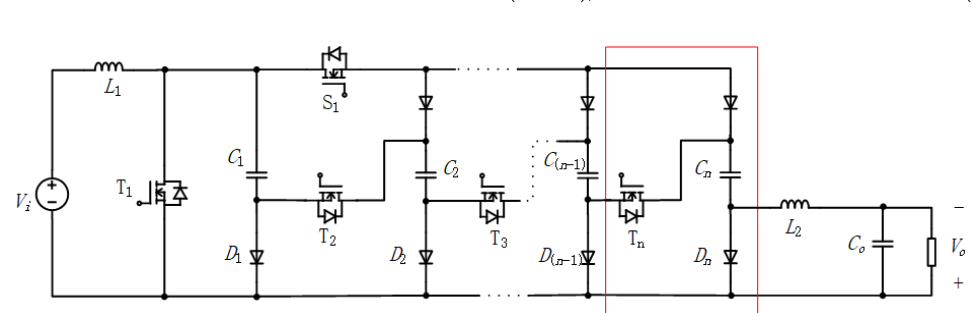
Figure 16. A Cuk-derived step-up/down SC converter in [34].